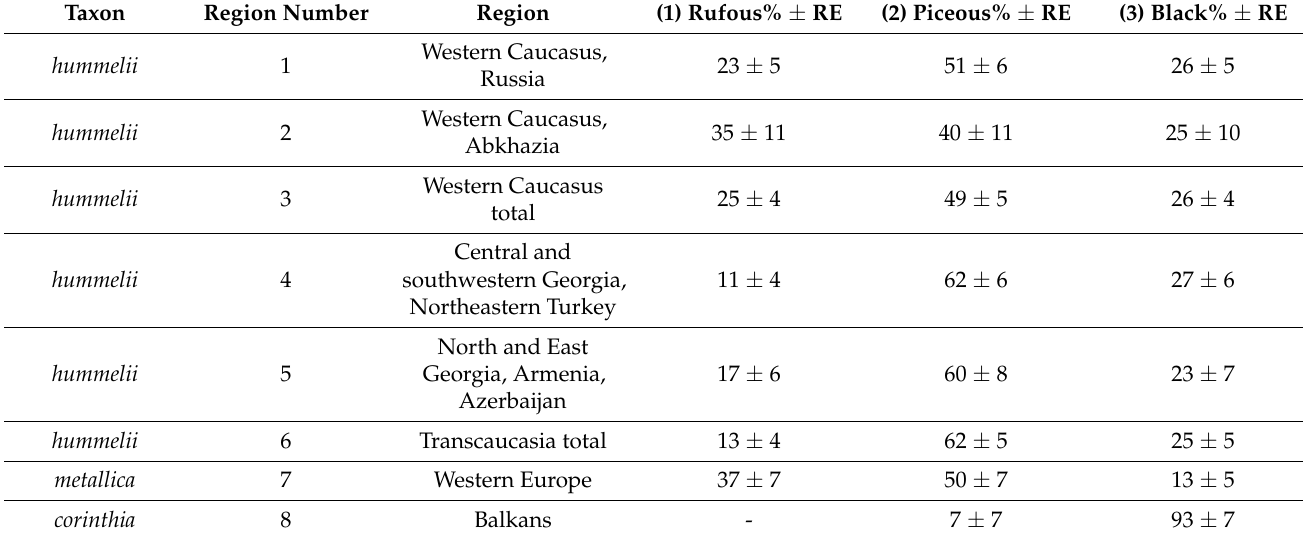
Table 9. Color of femora. RE—share representativeness